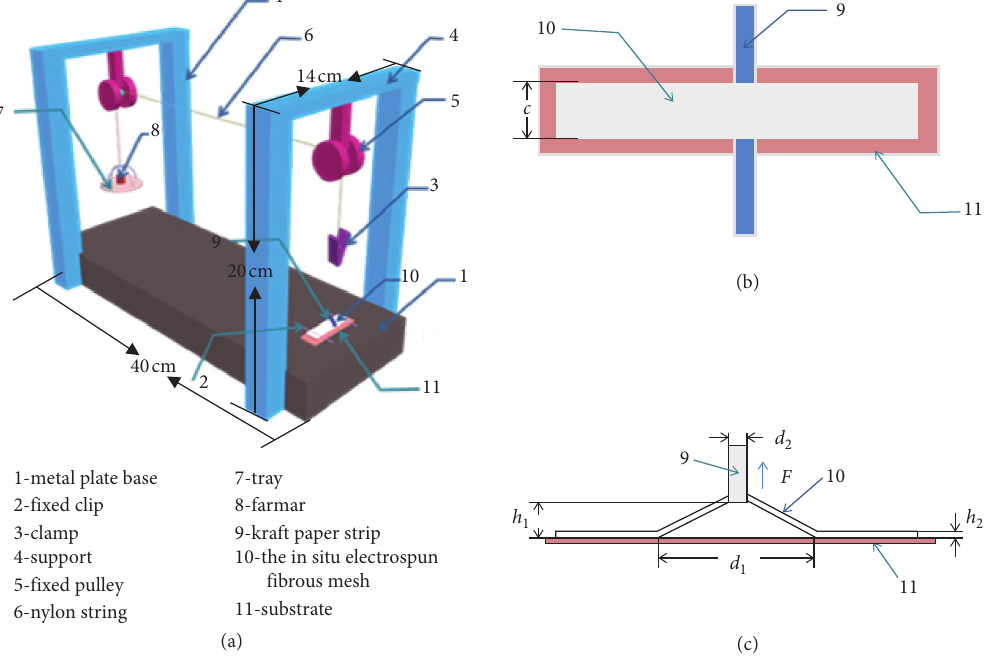
Figure 2: (a) The schematic diagram of the direct pulling apparatus for adhesion measurement. (b) Detail drawing of the substrate showing that nanofibrous mesh (with width of c ) was electrospun onto a substrate and a kraft paper strip was set between the as-spun mesh and the substrate. (c) A force ( F ) was applied on the electrospun membrane by pulling the kraft paper strip, thus forming a trapezoid shape and the bottom, and upper side length ( d 1 and d 2 ) as well as the pulling height ( h 1 ) and thickness of the electrospun mesh ( h 2 ) were recorded and analyzed to obtain the adhesion